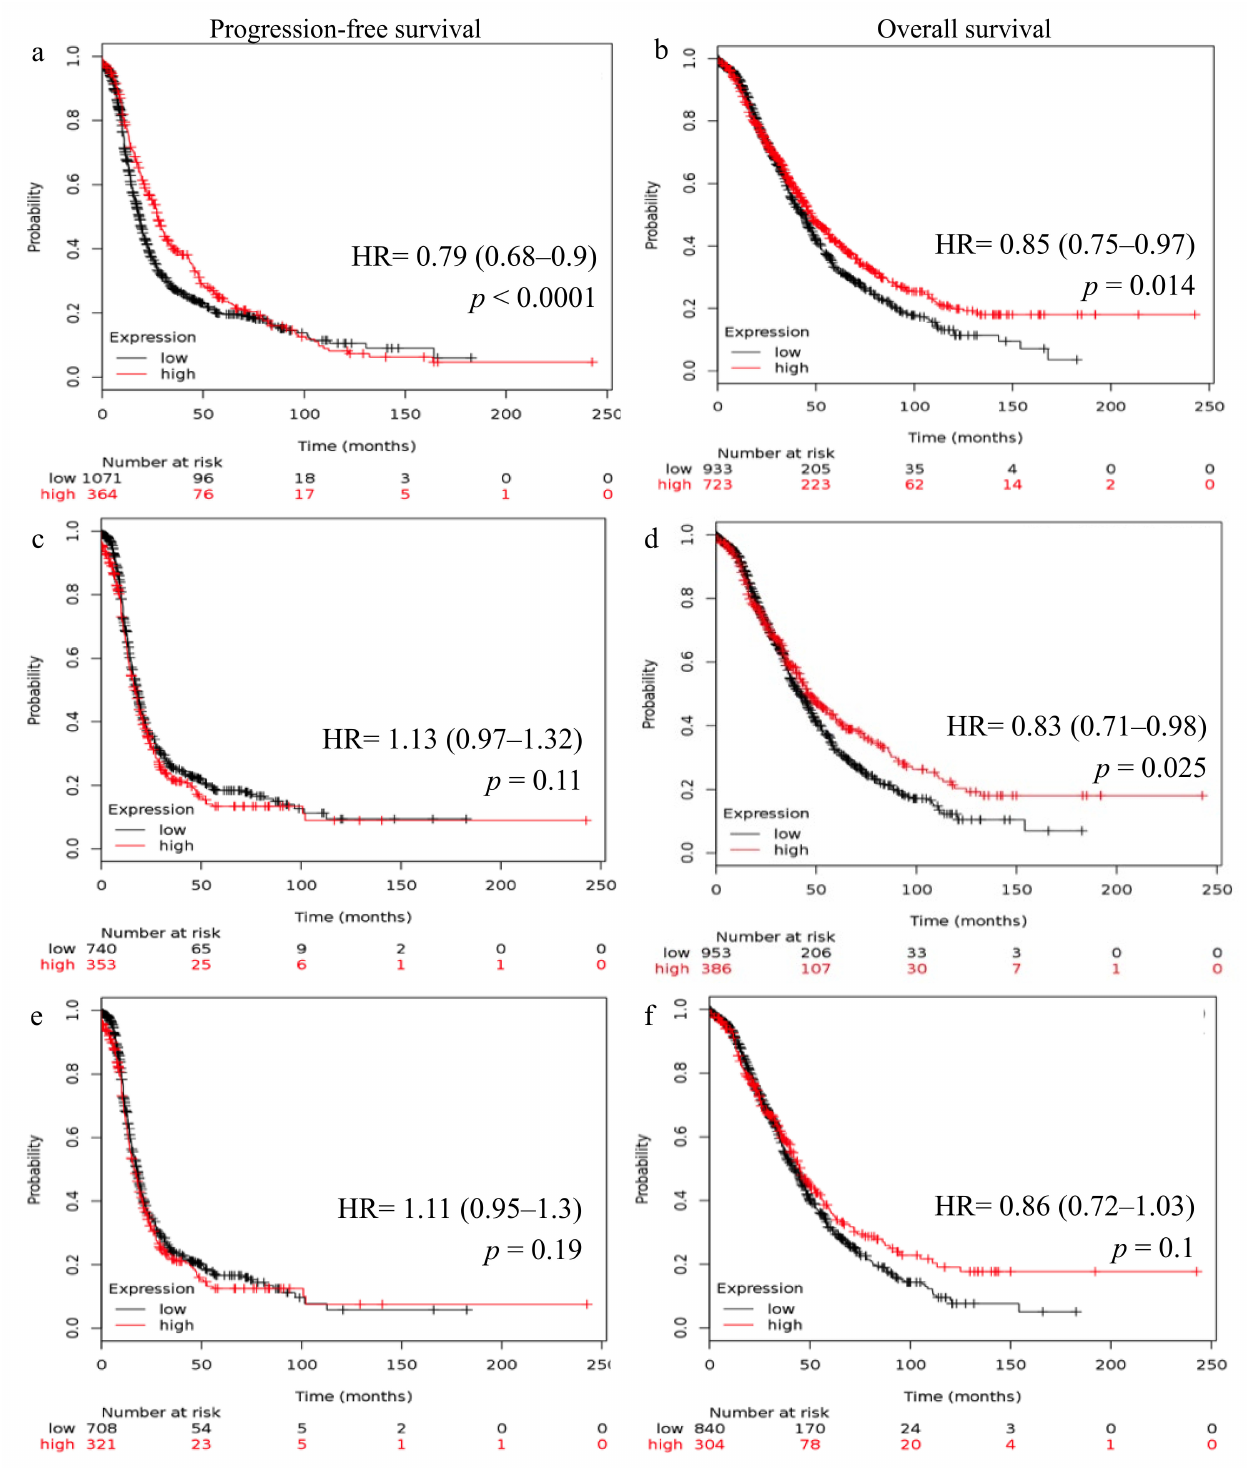
Figure 3. Kaplan–Meier survival analysis showing association of FSHR mRNA expression with ovarian cancer patient outcome. ( a ) FSHR, all ovarian cancers ( n = 1435) , progression-free survival (PFS) . ( b ) FSHR , all ovarian cancers ( n = 1656), overall survival (OS). ( c ) FSHR , high-grade ovarian cancers, ( n = 1093), PFS. ( d ) FSHR , high-grade ovarian cancers, ( n = 1339), OS. ( e ) FSHR , high-grade serous ovarian cancers, ( n = 1029), PFS. ( f ) FSHR , high-grade serous ovarian cancers ( n = 1144), OS. Patients were grouped using the best cut-off and hazard ratio (HR), 95% confidence intervals, log-rank test, p values were calculated by the Kaplan-Meier online plotter tool